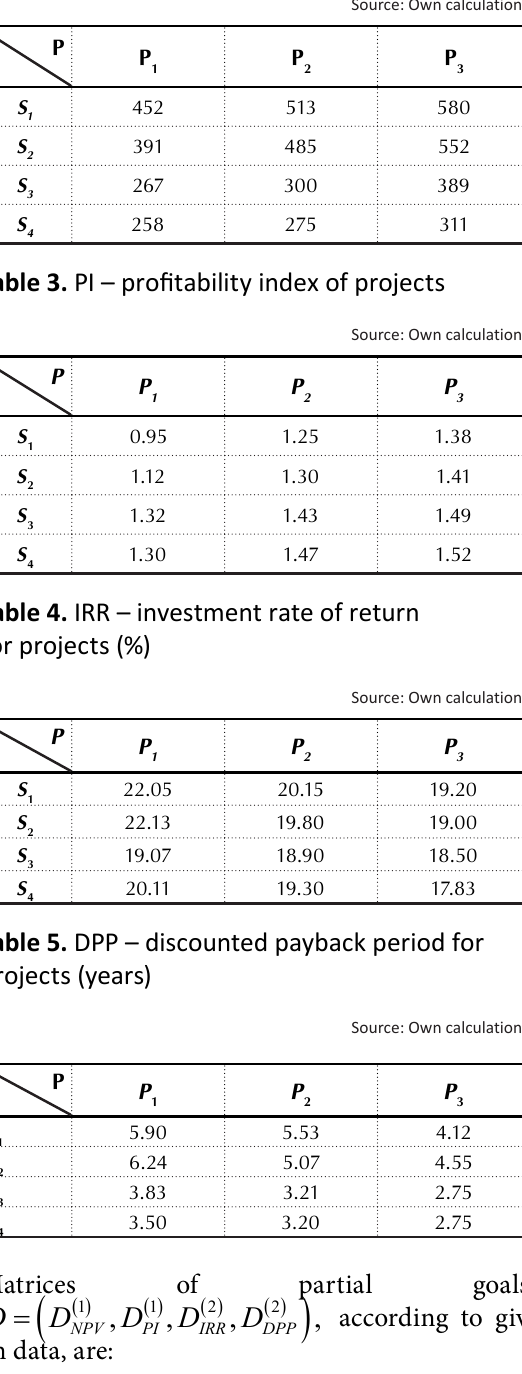
Table 2. NPV – net present value of projects